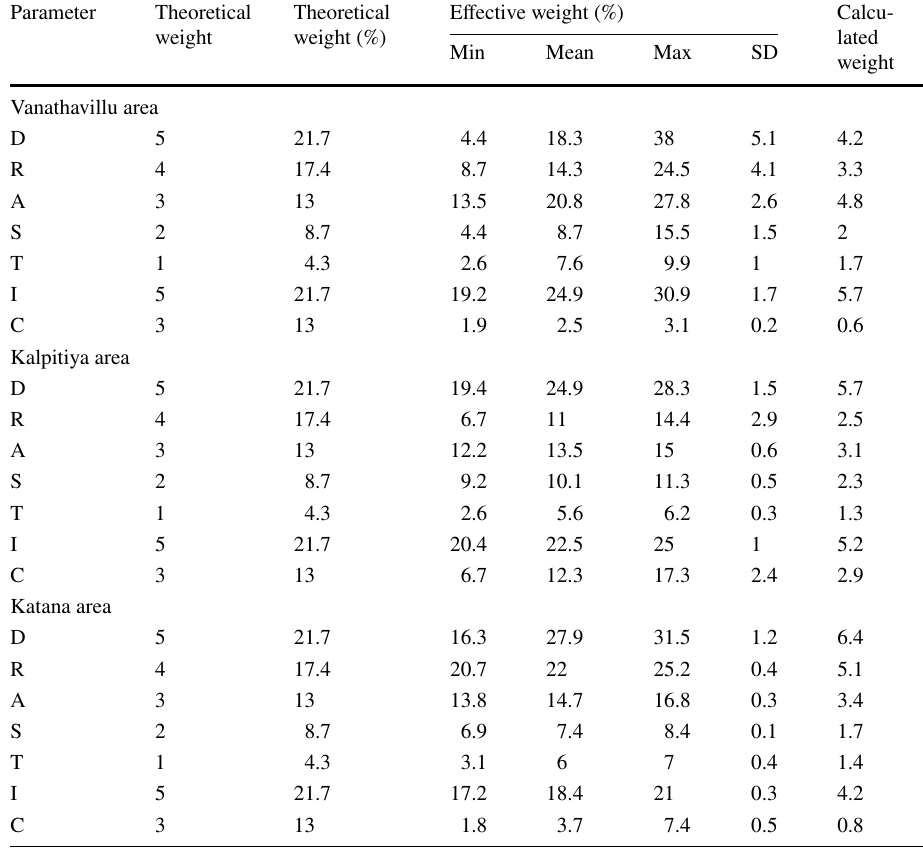
Table 5 Statistics of the single- parameter sensitivity analysis